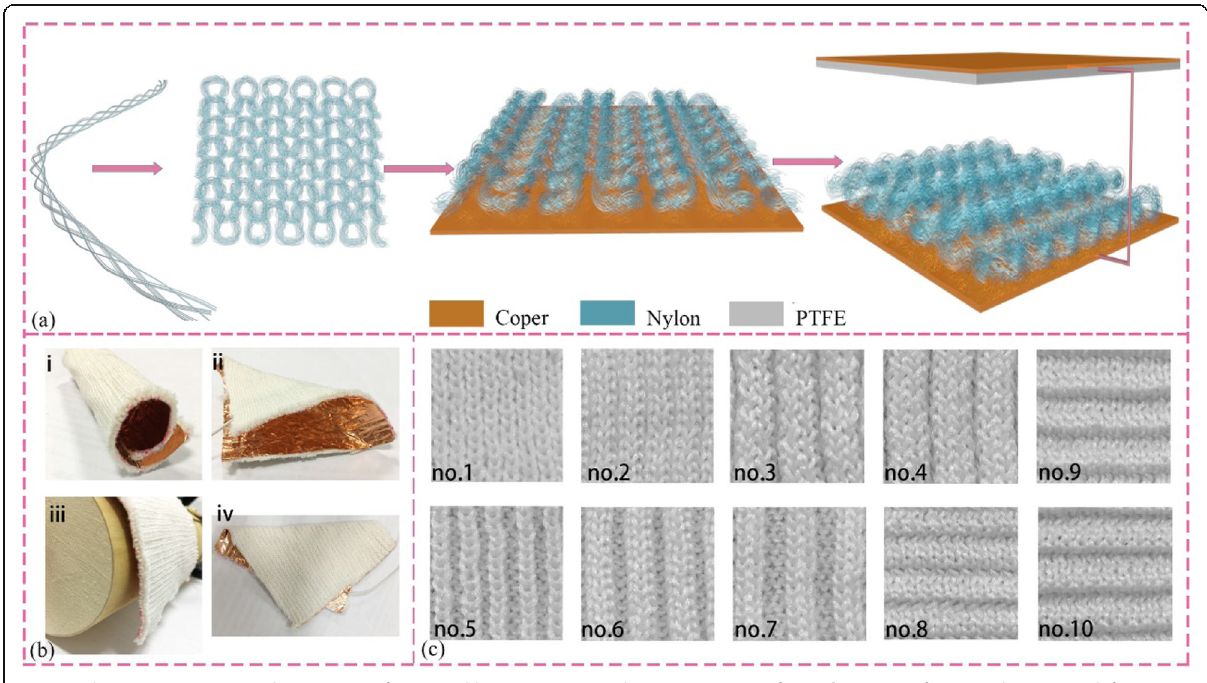
Fig. 1 Schematic preparation, characteristic of KNG, and knit structure. a Fabrication process of KNG. b Images of KNG under various deformation. i, crimped; ii, bent; iii, draped; iv, folded. c All of the fabricated knit structures, from number 1 to